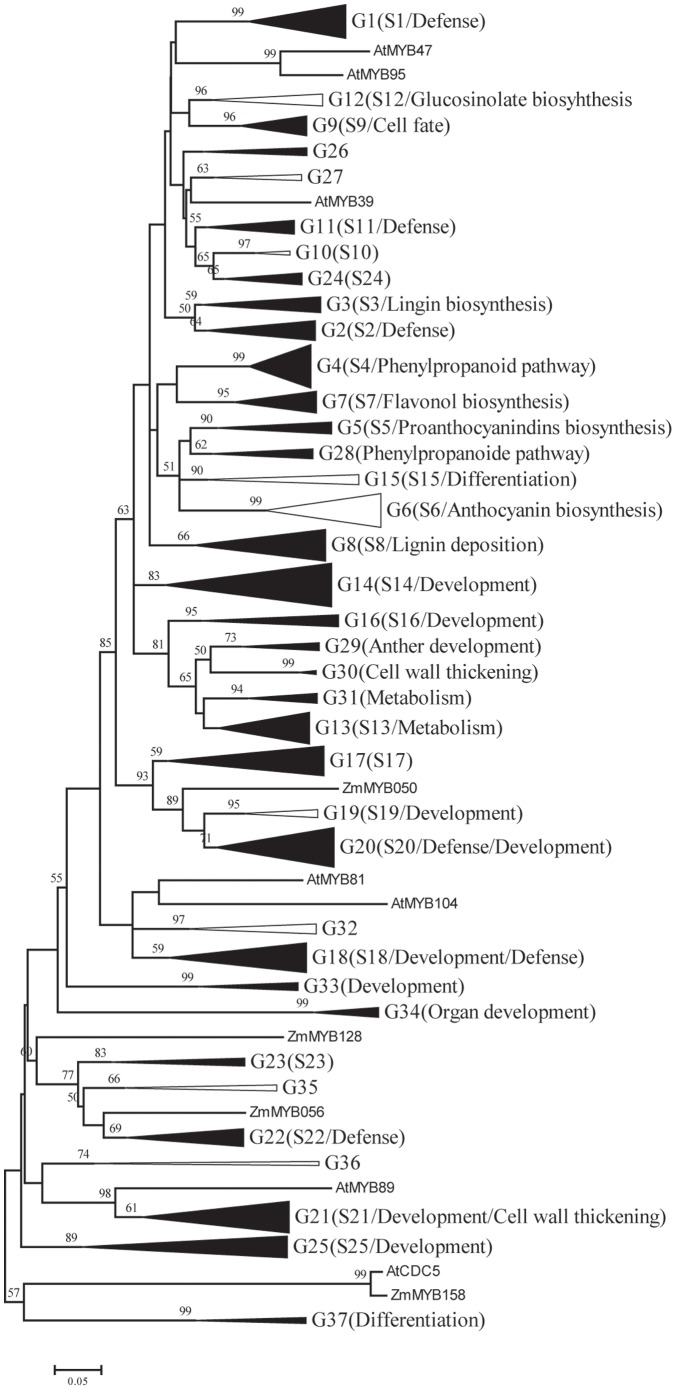
Phylogenetic tree of the R2R3-MYB proteins from maize (Zm), Arabidopsis (At), and other plant species.The neighbor-joining tree includes 158 R2R3-MYB proteins from maize, 126 R2R3-MYB proteins from Arabidopsis, and a further 52 R2R3-MYB proteins from other plant species. The proteins are clustered into 37 subgroups (triangles), designated with a subgroup number (e.g., G1). Subfamilies are represented as collapsed triangles, with depth and width proportional to sequence divergence and size, respectively. The black triangles indicate that the subgroup includes ZmMYBs and AtMYBs; the hatched and white triangles indicate that the subgroup includes or excludes ZmMYBs, respectively. Bootstrap values <50% are not shown in the phylogenetic tree. Four proteins did not fit well into clusters. The first 25 subgroups were designated as previously reports of AtMYBs by Stracke et al. (2001) and Dubos et al. (2010). The subgroups were listed in round bracket with annotated functions, for reference. 12 new subgroups were added because of the increased data set.